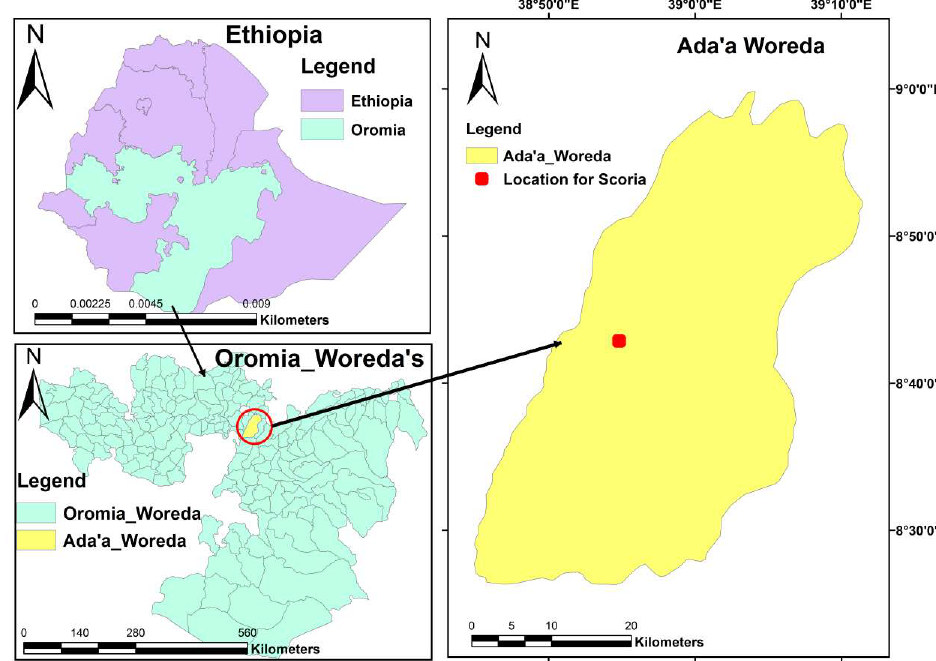
Figure 11. Sampling site of VSco.